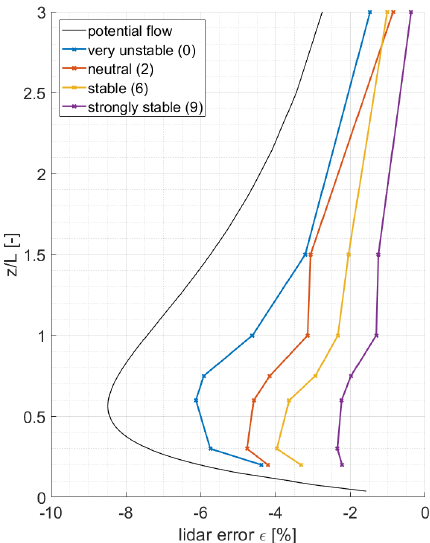
Figure 11. Lidar error ε in dependence of tree heights h t be- tween z/L ratios from 0 to 3. Results are based on Meteodyn WT (coloured) for medium forest density and the potential flow model (black) for an H/L ratio of 0.3.